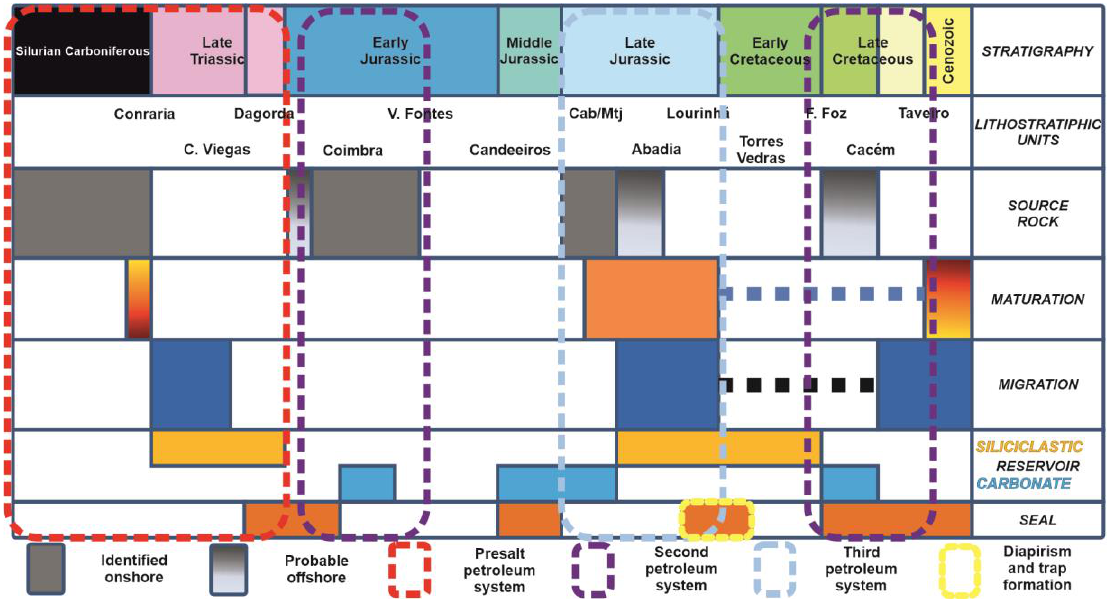
Figure 5. Simplified petroleum systems of the Lusitanian Basin. The Cabaços-Abadia petroleum system is shown within the blue dotted line, referring to the third petroleum system, adapted from Pena dos Reis and Pimentel [6]. The oil is generated in the marly limestones of the Cabaços Formation and migrates to the turbidite sandy reservoirs of the Abadia Formation